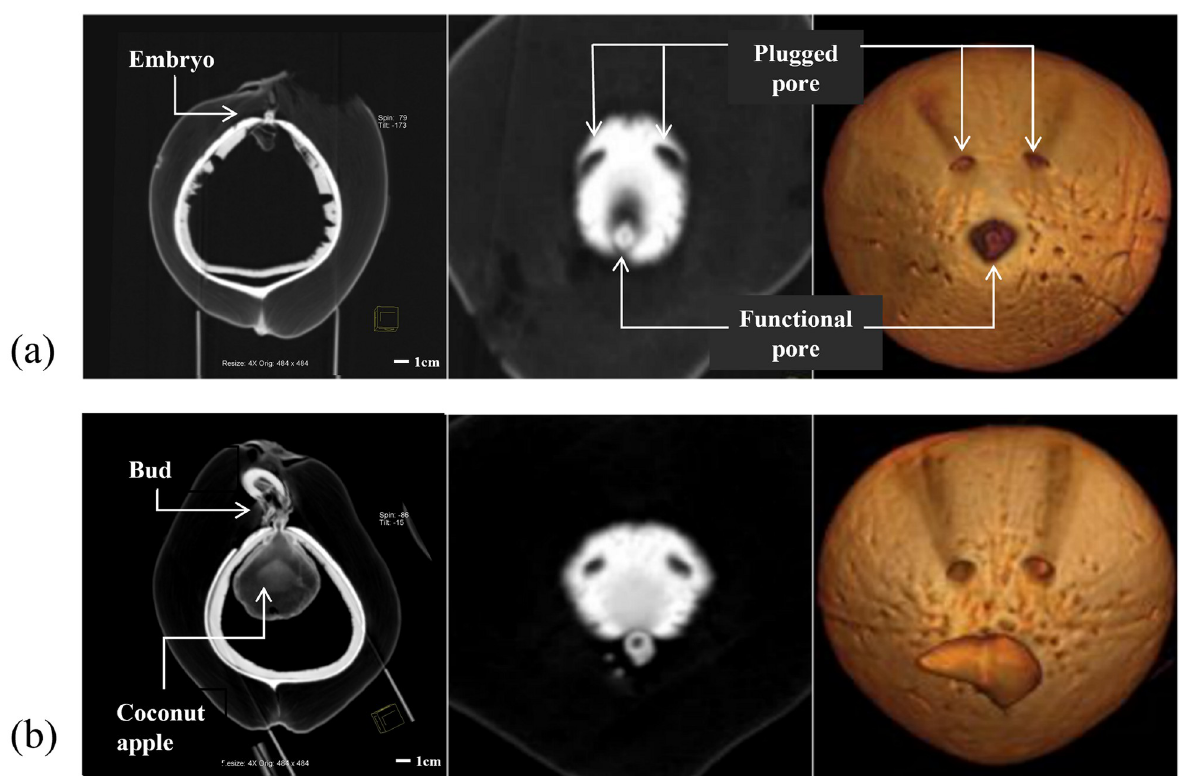
Fig 5. The structure of two coconuts (a, b). The multiplanar reformation on the left column show embryo, bud and coconut apples inside the coconut cavity. In the middle and right column, three pores on the surface of the endocarp and embryos sprouting from the largest pore.